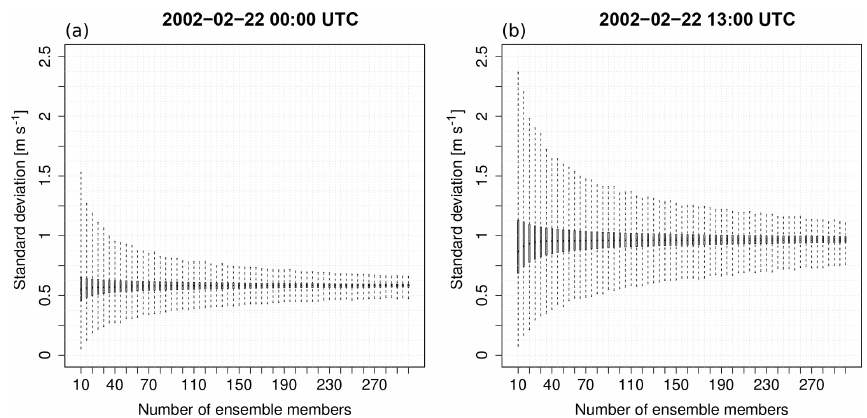
Figure 8. Box-and-whisker plots of the standard deviation of the 10m wind speed at 19.39 ◦ E, 56.17 ◦ N of 10 million samples of ensembles of size 10 to 300 randomly sampled from an ensemble with 500 members generated with WRF by applying SKEB and SPPT; shown are results for (a) 22 February 2002 00:00 and (b) 13:00UTC (compare with Fig.